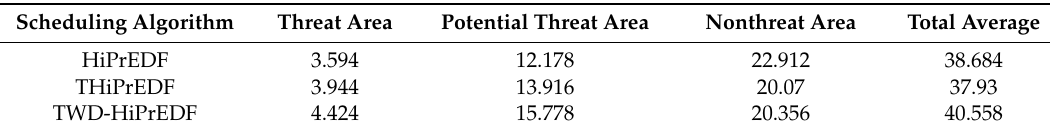
Table 7. The proportions of targets in different tracking areas in each scheduling interval under the Table 6. The average number of targets in the tracking state for each scheduling interval under the three scheduling algorithms. three scheduling algorithms.